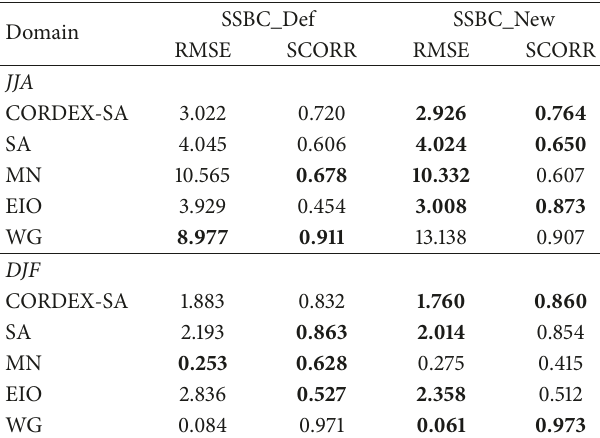
Table 4: Comparisons of the root-mean-square error (RMSE) and spatial correlation (SCORR) of SSBC_Def and SSBC_New summer (JJA) and winter (DJF) surface precipitation (mmd – 1 ) climatology with CMAP observations for 1981–1990 (the bold parts represent the best correlation and least